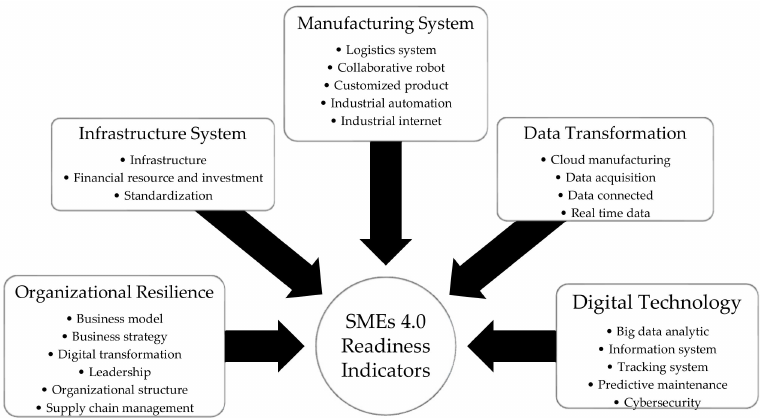
Figure 5. The aspect of SMEs 4.0 readiness